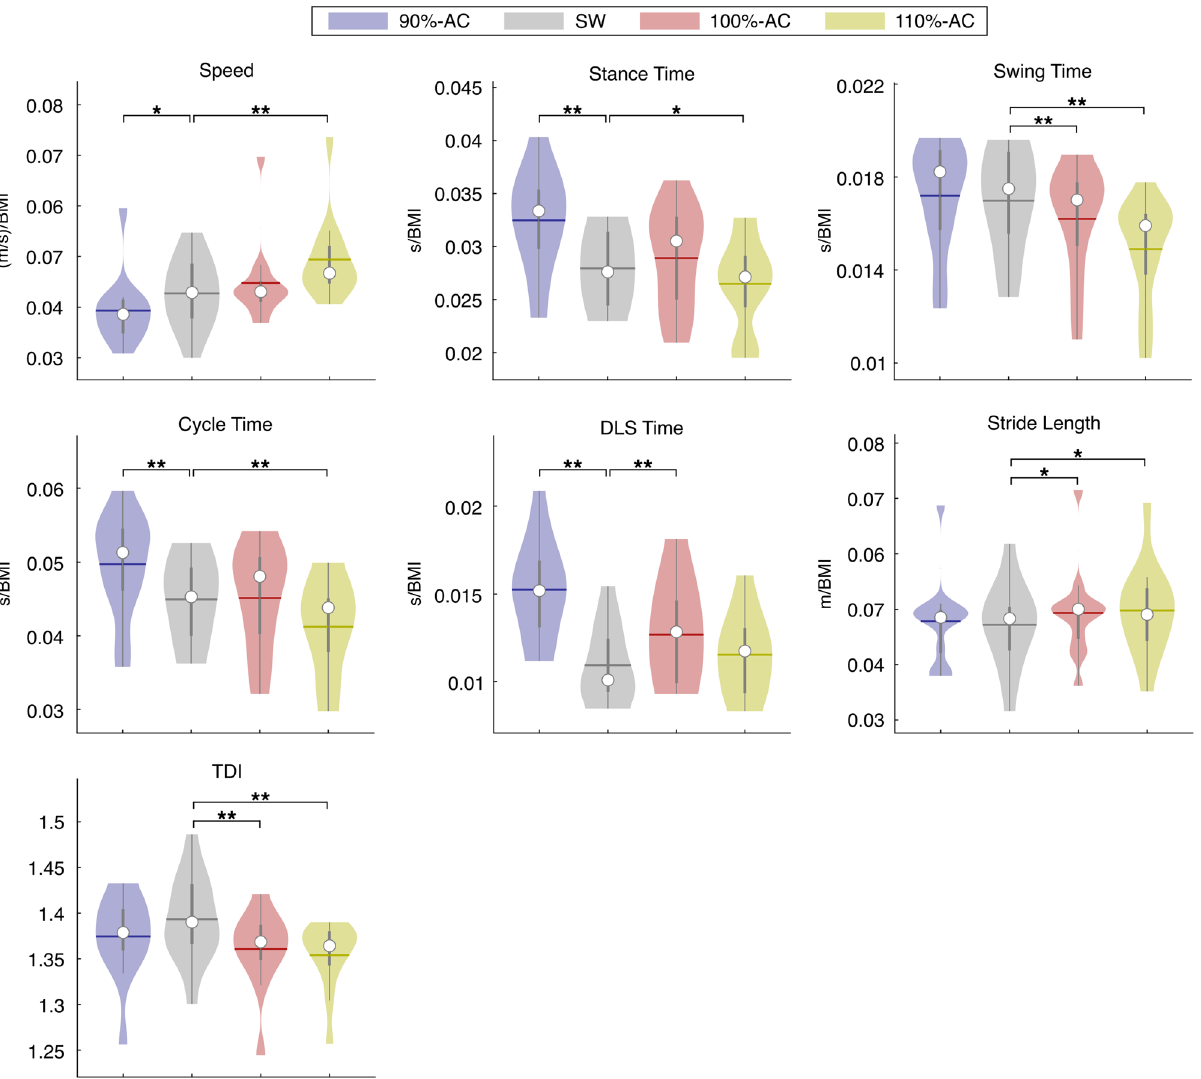
Figure 3. Spatiotemporal analysis of gait and Trunk Displacement Index (TDI). SW vs. RAS at fixed frequencies. Violin plots of spatiotemporal parameters and TDI value. Comparison between simple walking (SW) and walking with RAS at fixed frequencies expressed in beat per minute (bpm) (SW; 80 bpm; 120 bpm). DLS (double limb support), CV (coefficient of variability). Significance p value: *p < 0.05, **p < 0.01, ***p <